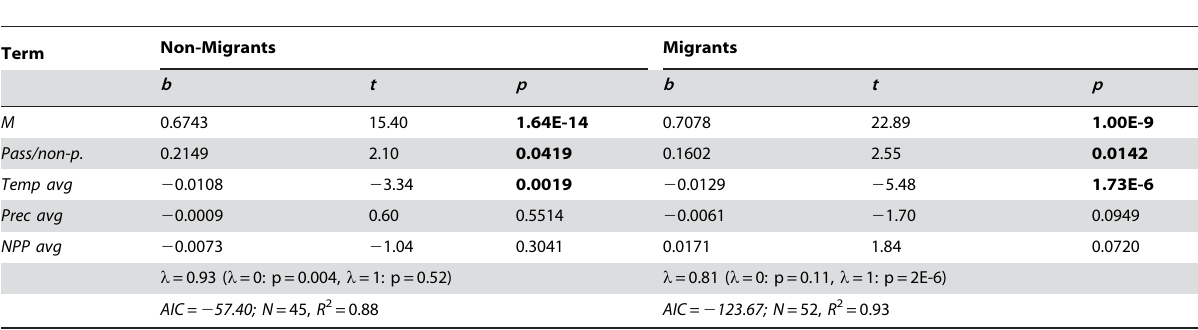
Table 5. Combined effects of select environmental variables on BMR in migrants and